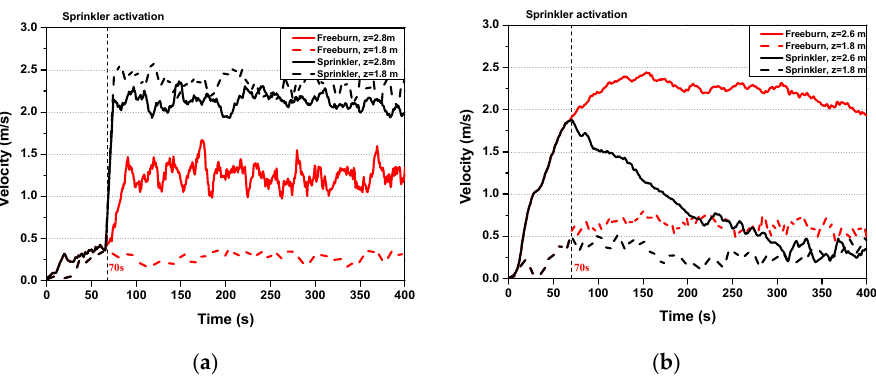
Figure 11. Variation in the velocity at ( a ) location A and ( b ) location B.